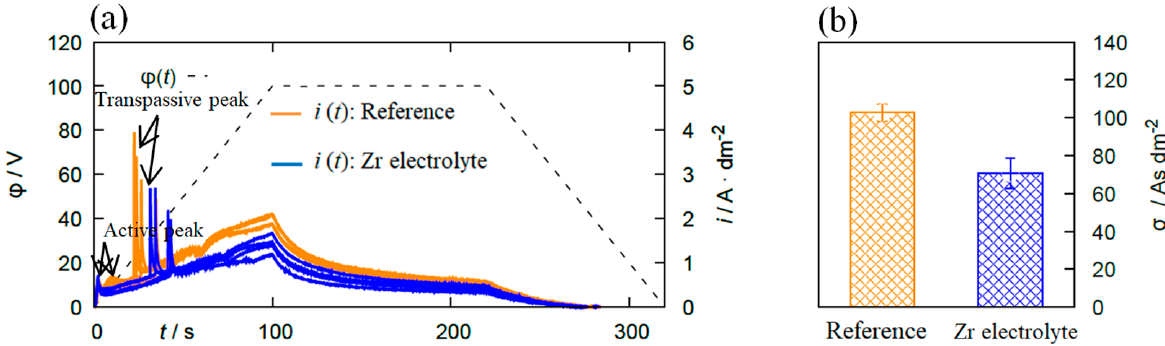
Figure 1. ( a ) ϕ ( t )- and i ( t )- diagrams of the polarization measurements recorded on 6082 Al alloy in the reference electrolyte and the Zr electrolyte. ( b ) The passivation parameter σ determined by integrating the i ( t ) curve between t = 100 and 220 s. With the addition of Zr-based salt into the electrolyte, the passive region of the substrate is extended, which indicates a positive effect regarding the passivation behavior.